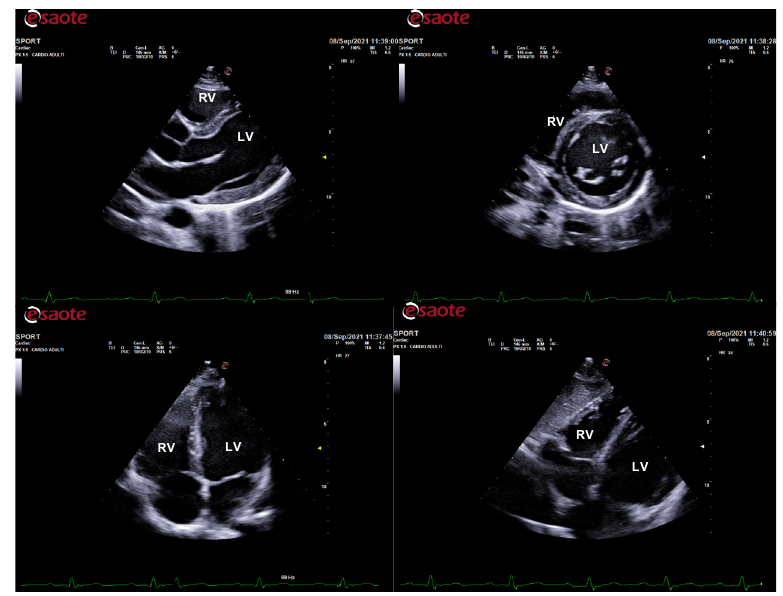
Figure 1. Standard echocardiography in an endurance athlete (cyclist). The physiological hypertrophy of the athlete’s heart is characterized by harmonic and symmetric wall thickening which is homogeneously distributed and involves all the cardiac chambers. In parasternal long-axis (top left), short-axis (top right), apical 4-chamber (bottom left), and subcostal (bottom right) views, both left and right chamber dilatation is evident. LV: left ventricle; RV: right